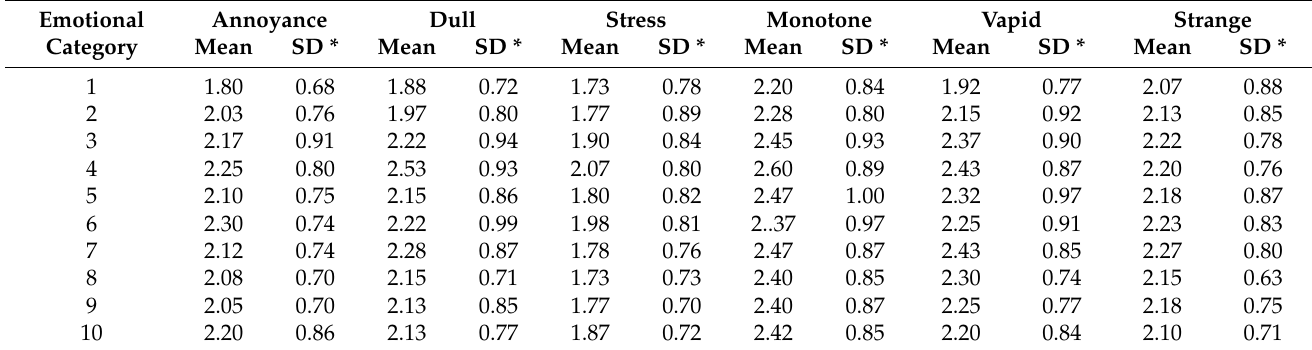
Table 14. Differences in negative emotion perception among samples.